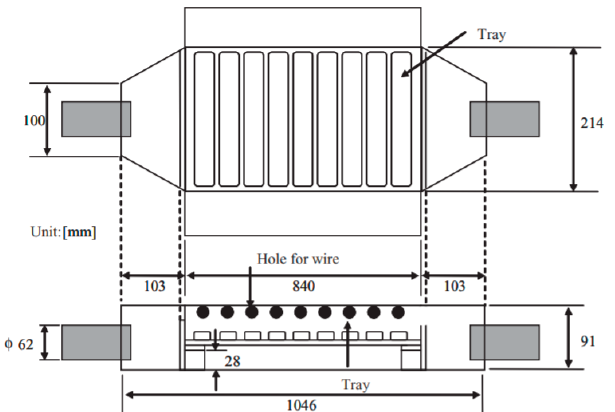
Figure 11. The schematic of PM removal device with wires electrode and trays electrode. Reprinted from Reference [93], with permission from John Wiley and Sons.